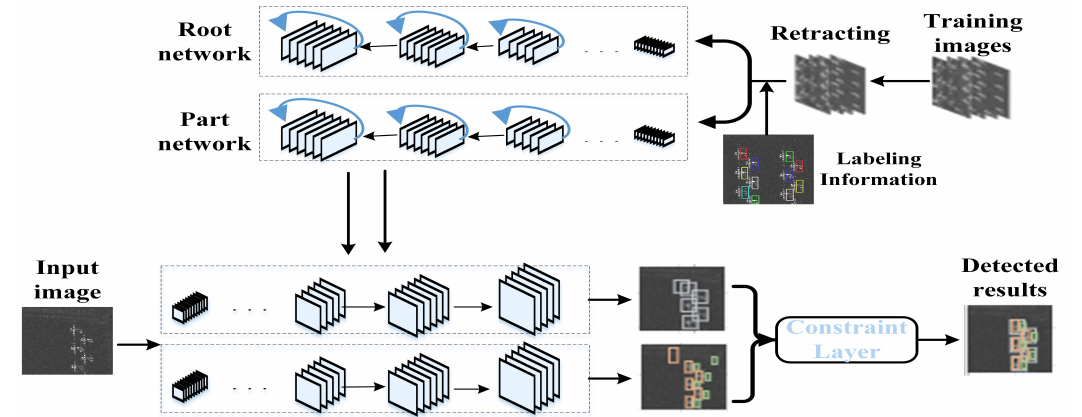
Figure 4. Algorithm flow